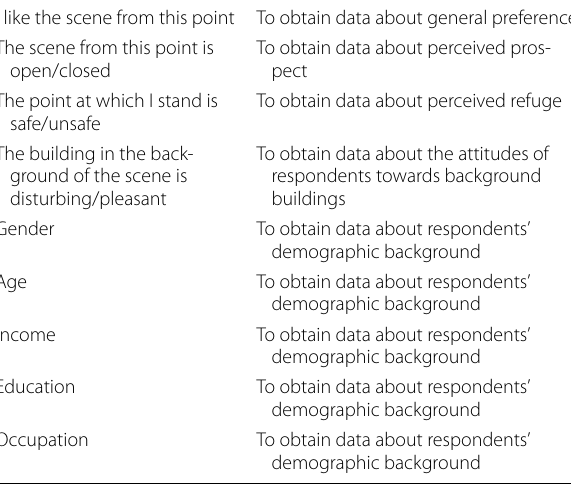
Table 1 Questionnaire items and logic behind